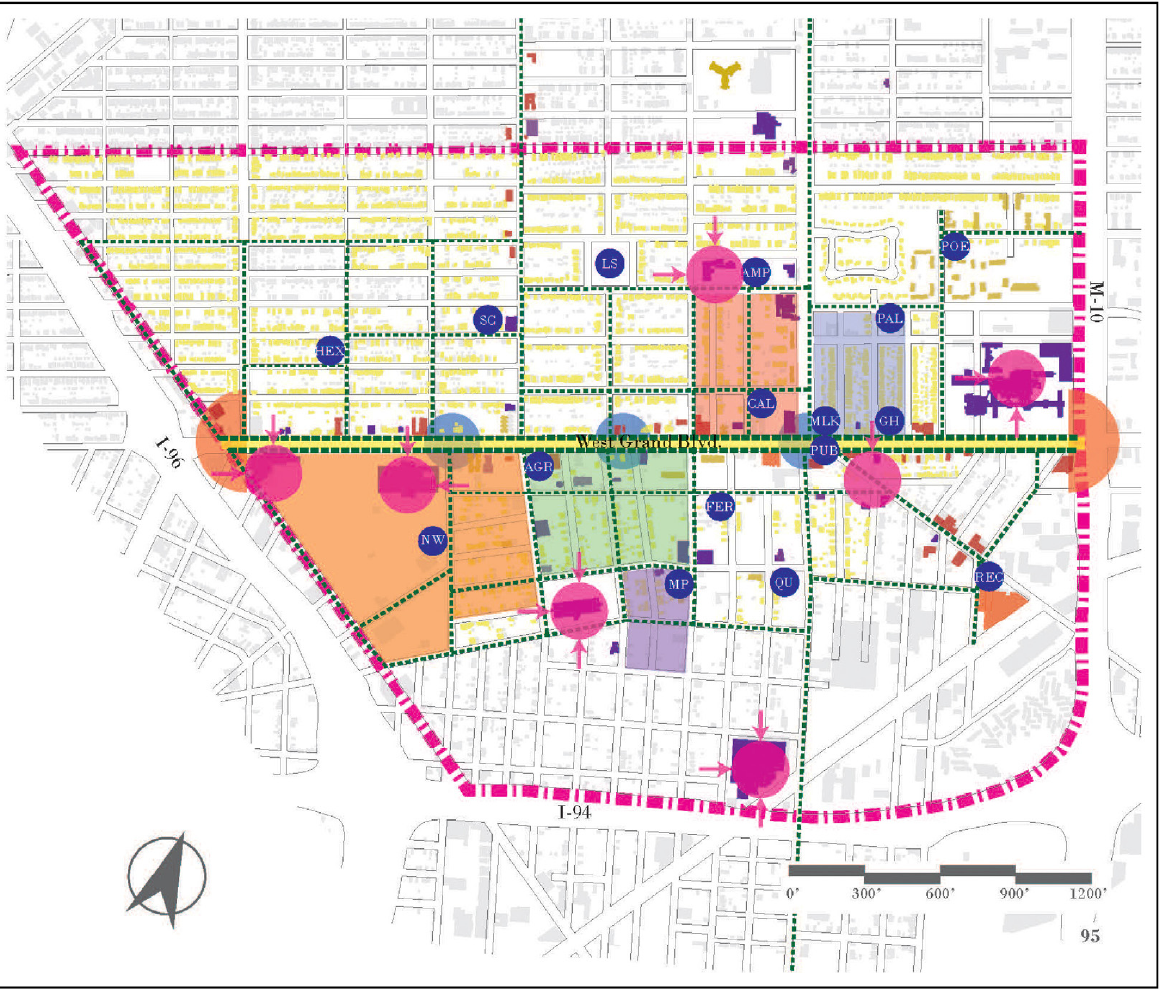
Figure 9. An example of a community vision concept map showing MBP locations (multi-purpose bike parks: dark-blue small circles).